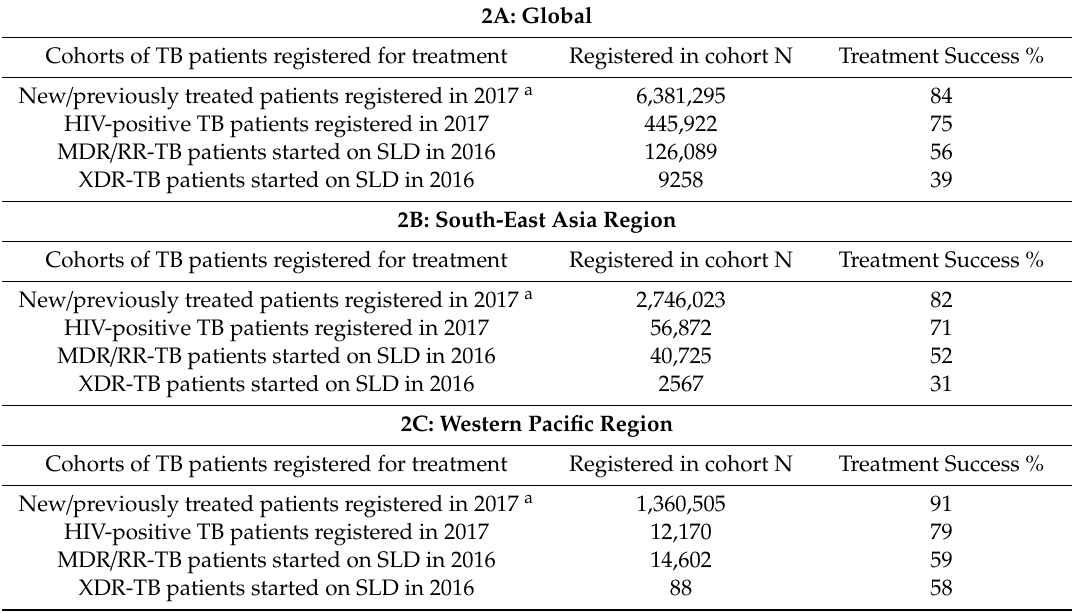
Table 2. Treatment success in cohorts of TB patients registered for